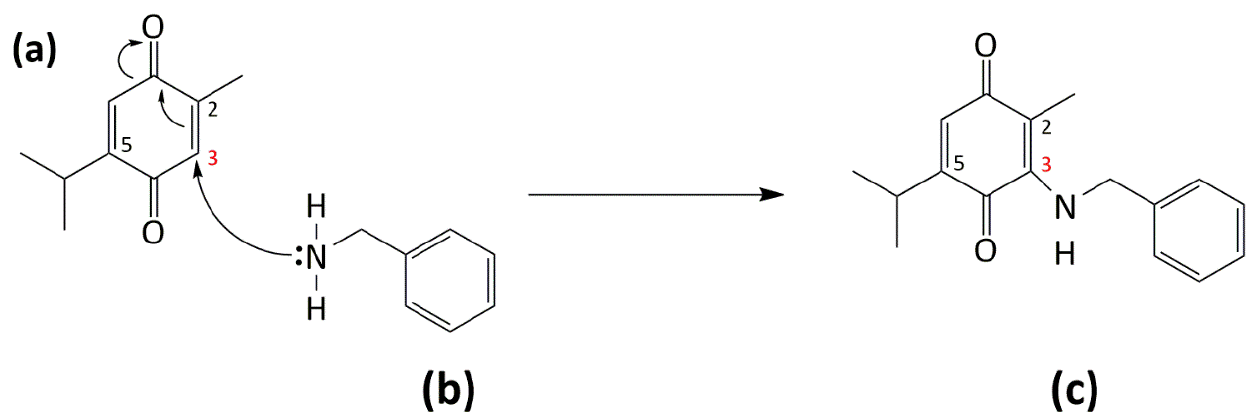
Figure 11. Synthesis of TQ1 ( c ) by Michael addition reaction of benzylamine ( b ) and TQ ( a ) with the less nucleophilic nitrogen attacking carbon 3 of TQ.